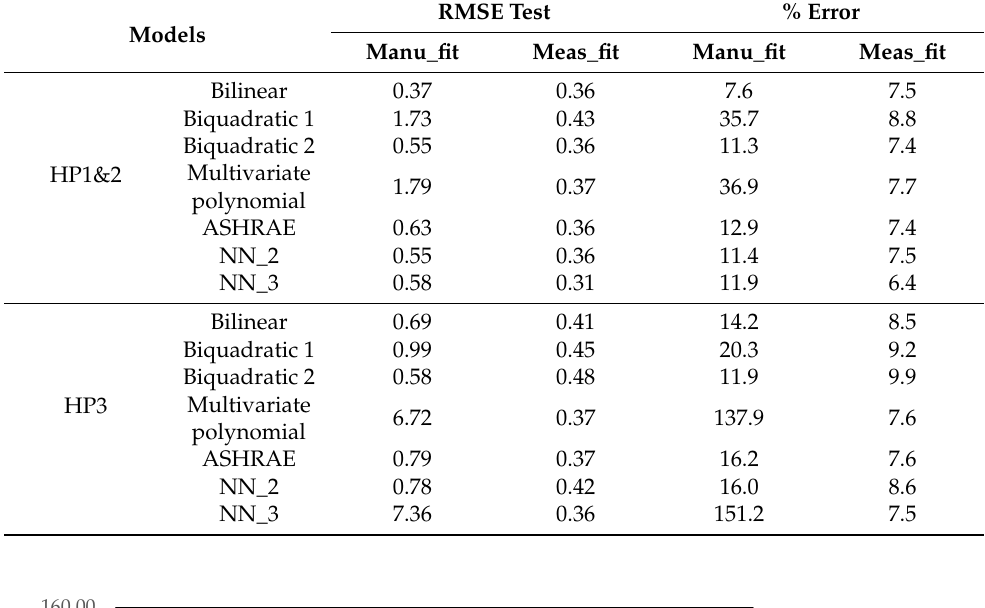
Table 5. Error of models for testing data.